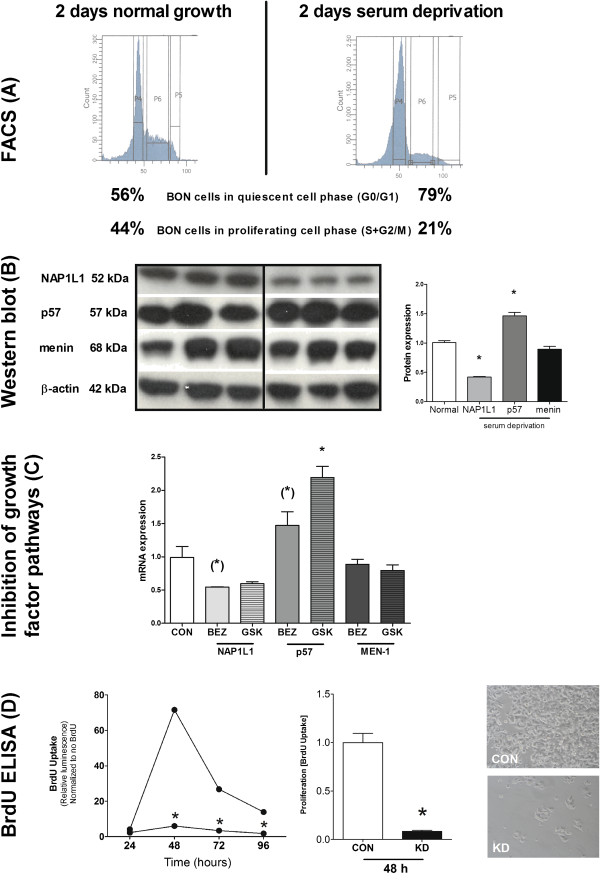
The effect of NAP1L1 on tumor cell proliferation in vitro. In proliferating BON cells, 56% were in the quiescent cell phase (G0/G1) and 44% in the proliferating cell phase (S and G2/M). After two days of serum deprivation, 80% of the cells were quiescent (A). A decrease of NAP1L1 (*p < 0.05) and an increase of p57Kip2 (*p < 0.05) protein expression were evident (B). Inhibiting proliferation by targeting the mTOR pathway (BEZ235) and ERK pathway (GSK1120212) resulted in a similar pattern of expression: NAP1L1 tended to be decreased ((*) p = 0.06) and p57Kip2 was increased (*p < 0.05) while menin did not alter (C). BON cells without NAP1L1 did not grow (*p < 0.0001) and exhibited decreased cell numbers (D). Mean ± SEM.